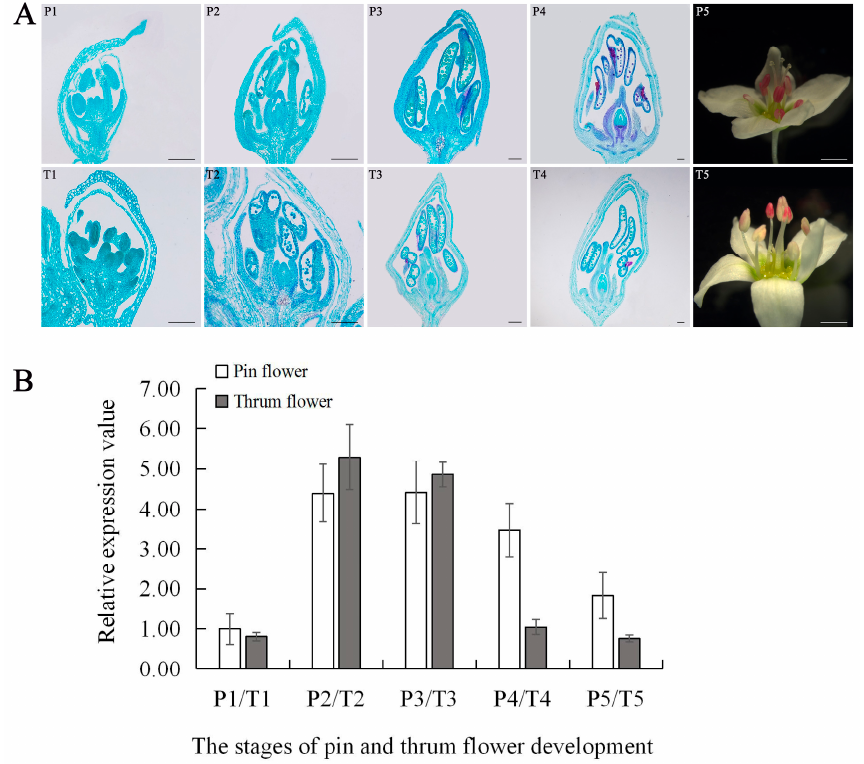
Figure 5. Morphology and FaesAP1 expression in buckwheat Heterodistylous flowers at di ff erent developmental stages. ( A ) Morphology of dimorphic flowers at various development stages; P1–P5: morphological di ff erentiation and development of the pin flower; P1: Tepal primodium,